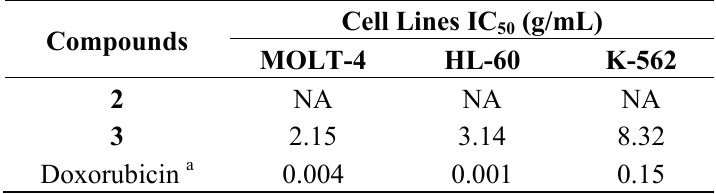
Table 2. Cytotoxic data of steroids 2 and 3